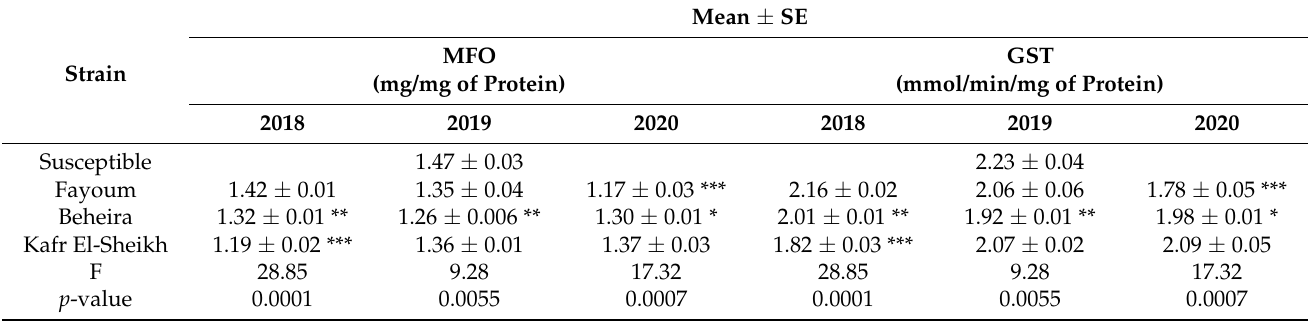
Table 7. MFO and GST enzyme activity (Mean ± SE) in field strains of Spodoptera littoralis over three consecutive seasons (2018 to